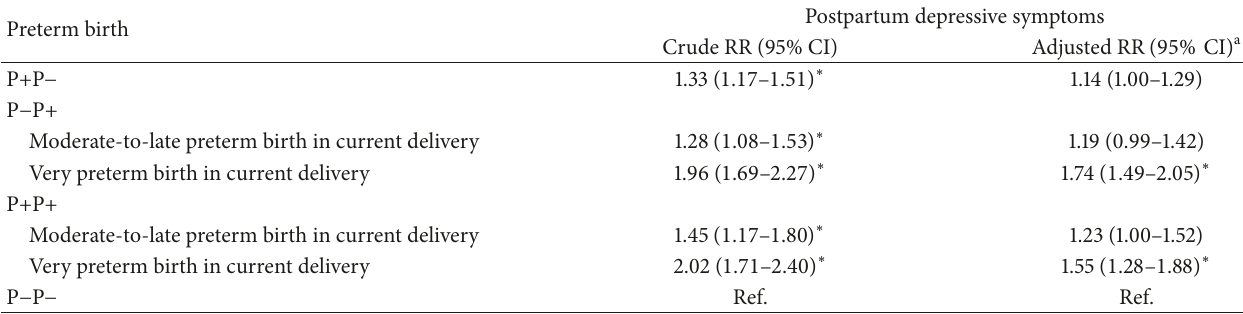
Table 3: Association between preterm birth and postpartum depressive